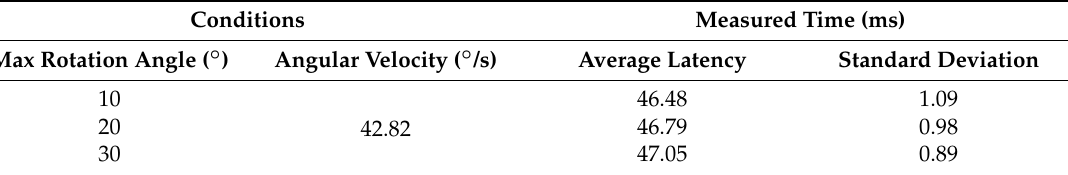
Table 3. Average latencies and standard deviations for different rotation angles (pitch rotation).